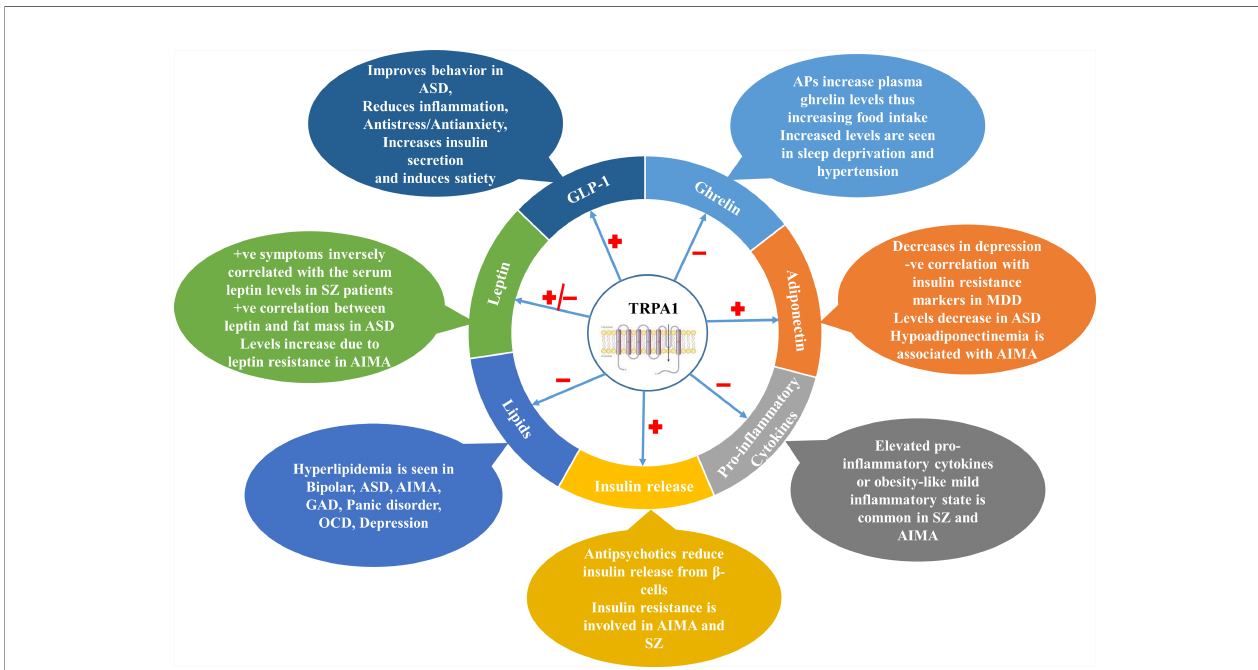
FIGURE 1 | Involvement of TRPA1 channels in various NPDs through different metabolic markers. TRPA1 channels modulate various metabolic parameters such as Ghrelin, Leptin, GLP-1, Adiponectin in the body which are involved in the pathophysiology of various NPDs. They also regulate insulin release from pancreatic b -cells, pro-in fl ammatory cytokine release and lipid balance in the body. ASD, Autism Spectrum Disorder; APs, Antipsychotics; AIMA, Antipsychotics-induced metabolic alterations; MDD, Major Depressive Disorder; GAD, General Anxiety Disorder; OCD, Obsessive Compulsive Disorder; GLP-1, Glucagon-like Peptide-1; TRPA1, Transient Receptor Potential Channel Ankyrin 1; SZ,